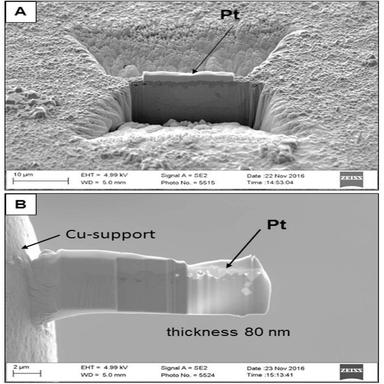
(A) - SEM image of the surface of a Cr2O3 scale formed on chromium with implanted yttrium ions (2 × 1016 Y/cm2 ) after 100 h of oxidation at 1073 K at the location at which a lamella had been cut; (B) – Lamella for TEM/ STEM-EDS analyses.